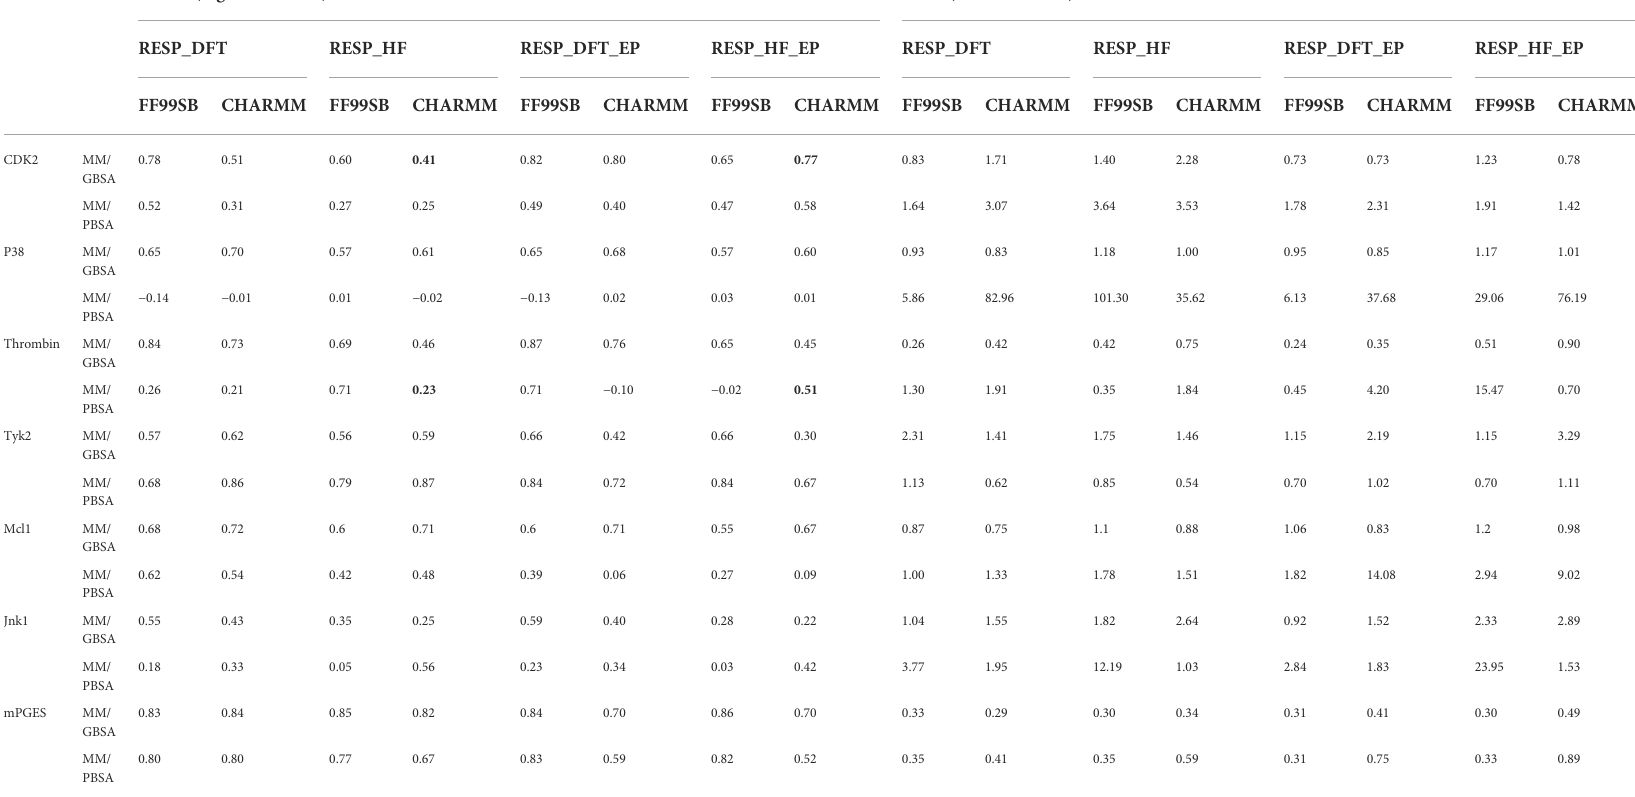
TABLE 2 The Pearson correlation coef fi cient (R) and mean absolute error (MAE) with/without adding extra points. obs. R (higher is better) MAE (lower is better) RESP_DFT